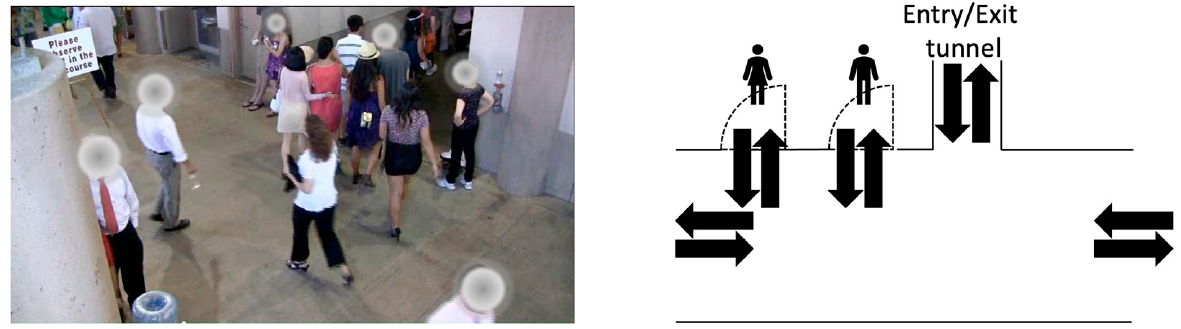
Figure 9. Top-view floor plan of the recorded location at the Stanford Stadium. Pedestrians are crowded at the entry/exit tunnel as they attempt to leave the stadium.